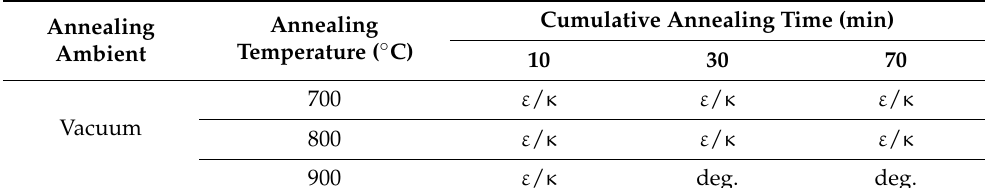
Figure 6. ( a ) Detailed time evolution of the in situ XRD symmetric 2 θ / ω scans acquired at the annealing temperature of 1100 ◦ C. ( b ) 2 θ / ω scans of the films before and after the high-temperature annealing cycle shown in Figure 4. Table 2. Summary of annealing conditions and their influence on the degradation of ε / κ -Ga 2 O 3 grown on sapphire using LI-MOCVD.